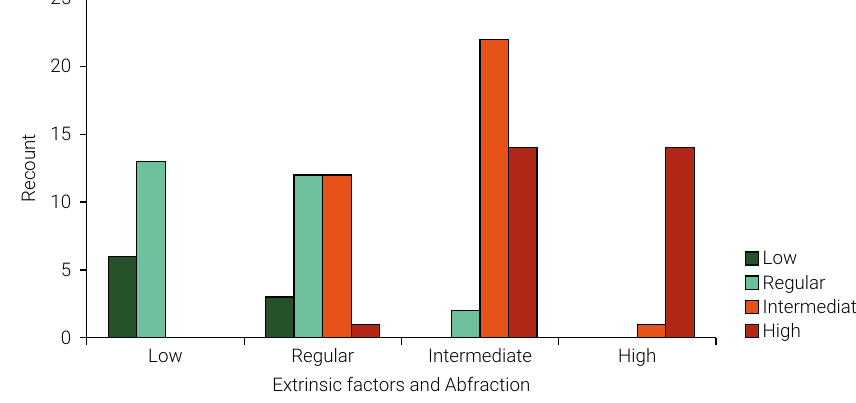
Figure 4. Percentage of extrinsic factors and abfraction.